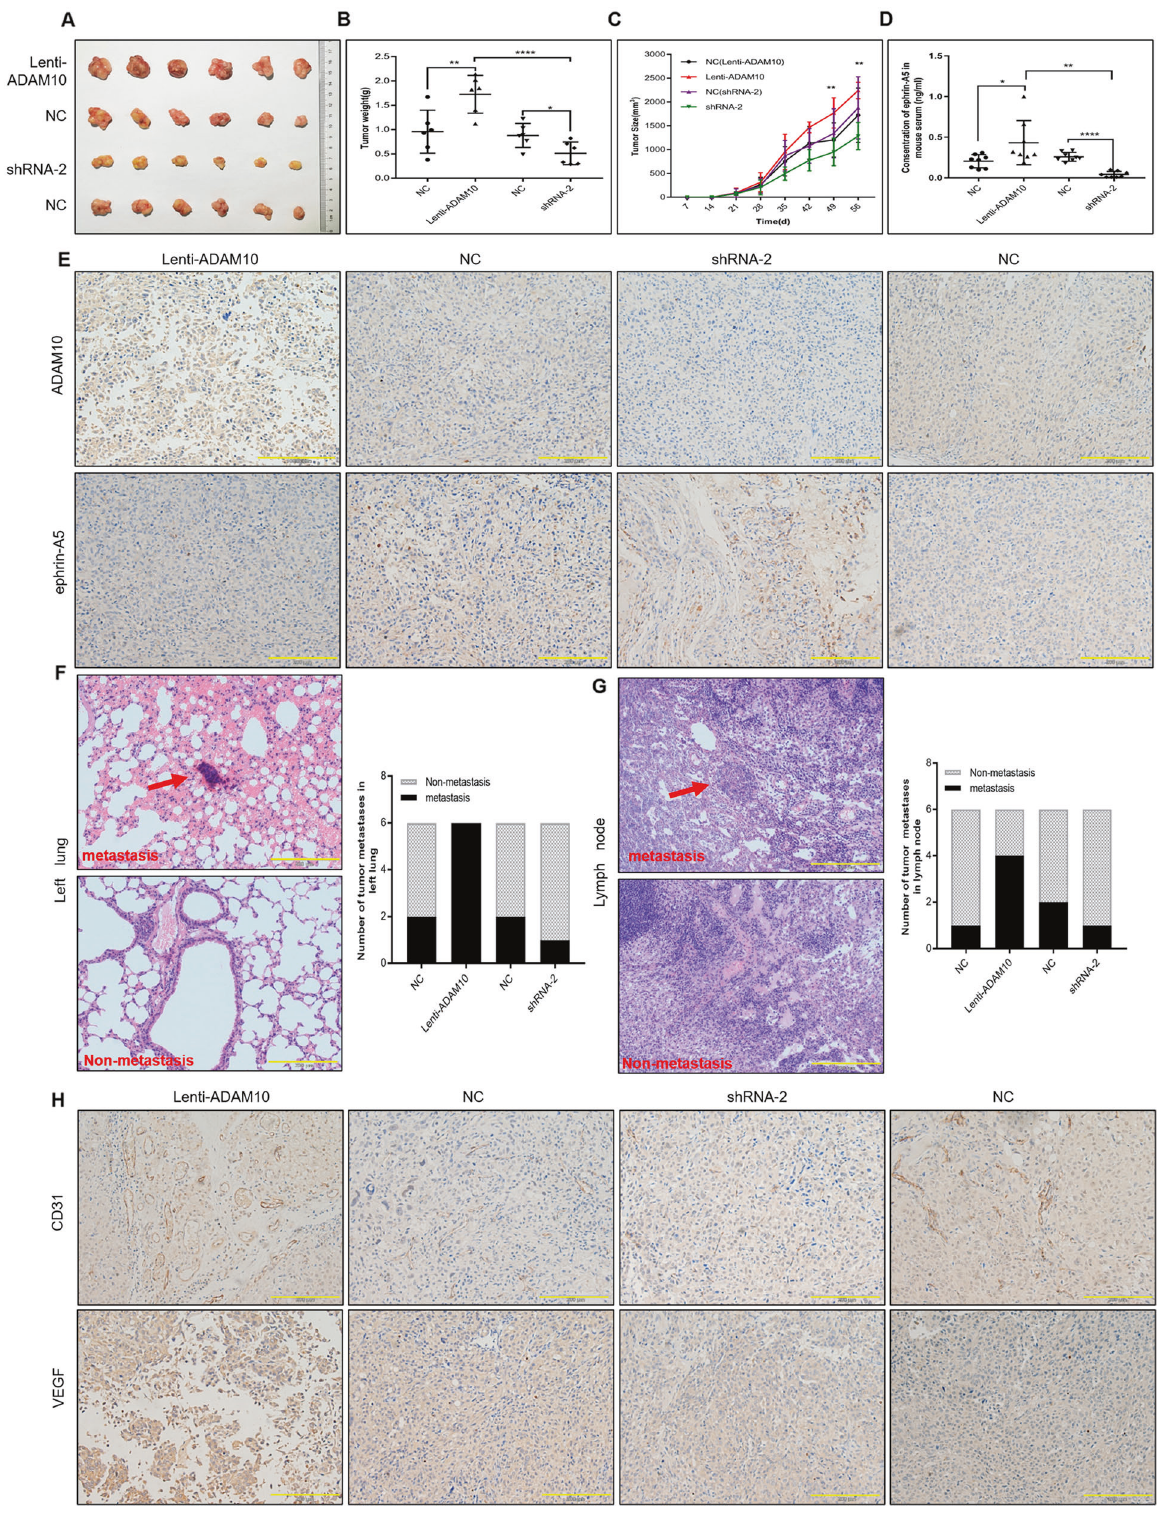
Fig. 6 ADAM10 cleaves ephrin-A5 and promotes tumor metastasis in vivo. A – C Tumor volume and weight at the end of the experiment. The data are shown as the means ± sd ( n = 6), * P < 0.05, ** P < 0.01, **** P < 0.0001. D The serum ephrin-A5 content of nude mice in each treatment group was detected by ELISA ( n = 6), * P < 0.05, ** P < 0.01, **** P < 0.0001. E The expression levels of ADAM10 and ephrin-A5 in tumor tissues were detected by immunohistochemistry, Scale bar, 200 µm. F HE staining was used to detect tumor metastasis in the left lung of nude mice (left), statistics of tumor metastasis rate in each treatment group (right). Scale bar, 200 µm. G HE staining was used to detect tumor metastasis in the lymph node of nude mice (left), statistics of tumor metastasis rate in each treatment group (right). Scale bar, 200 µm. H The expression levels of CD31 and VEGF in tumor tissues were detected by immunohistochemistry. Scale bar, 200 µm.